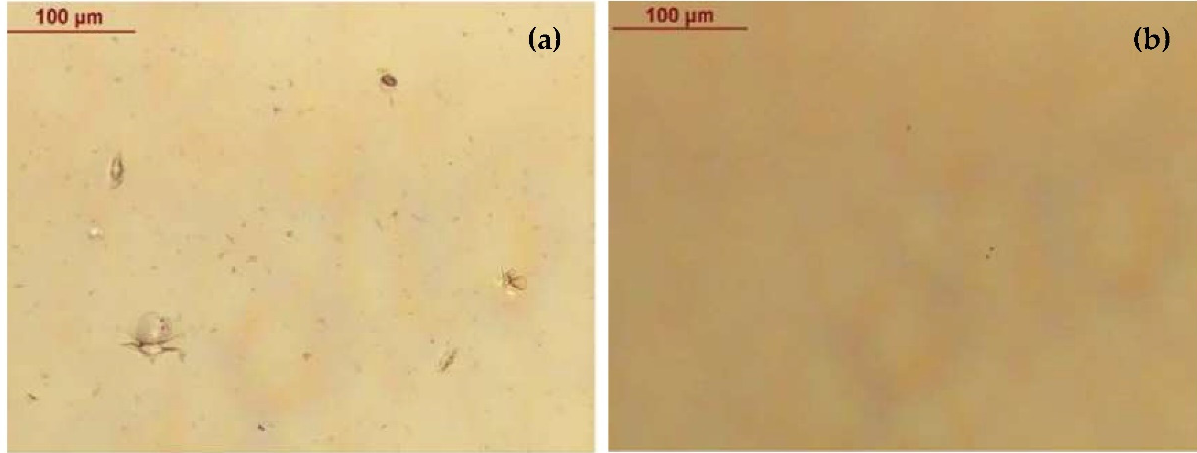
Figure 2. Optical microscope images of samples facing the west ( a ) and north ( b ) directions [13].